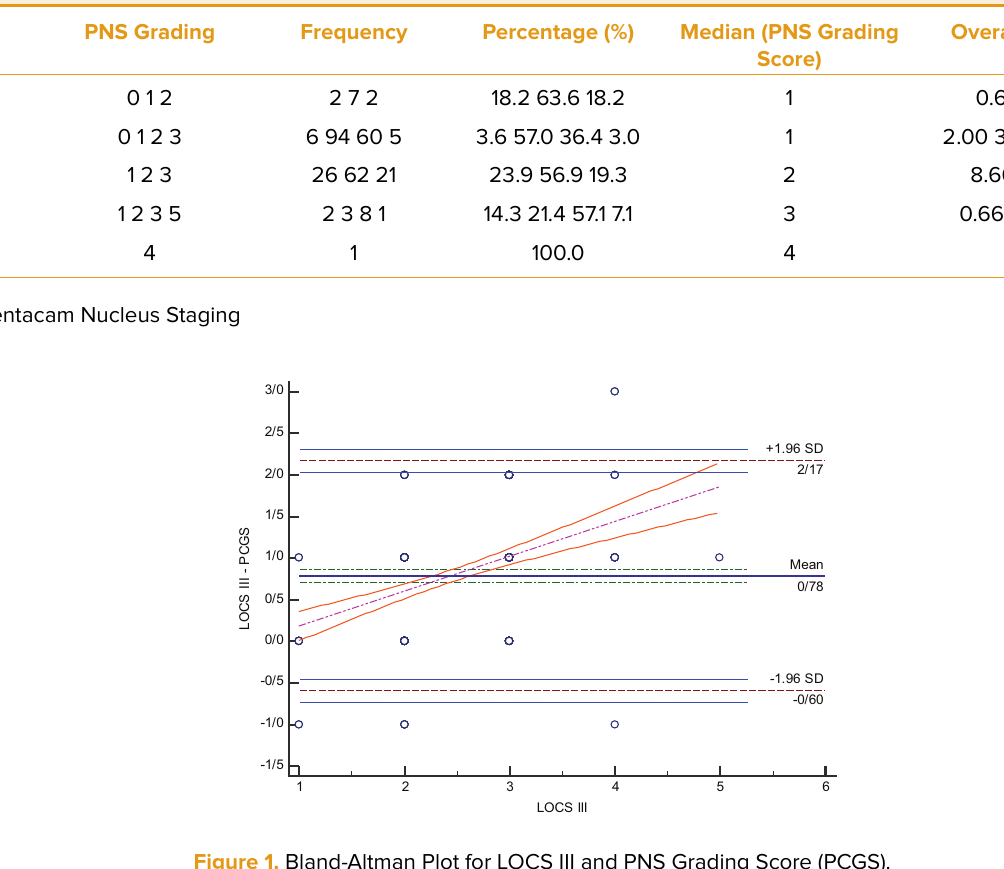
Table 1. PNS Grading Score based on LOCS Ill classification.